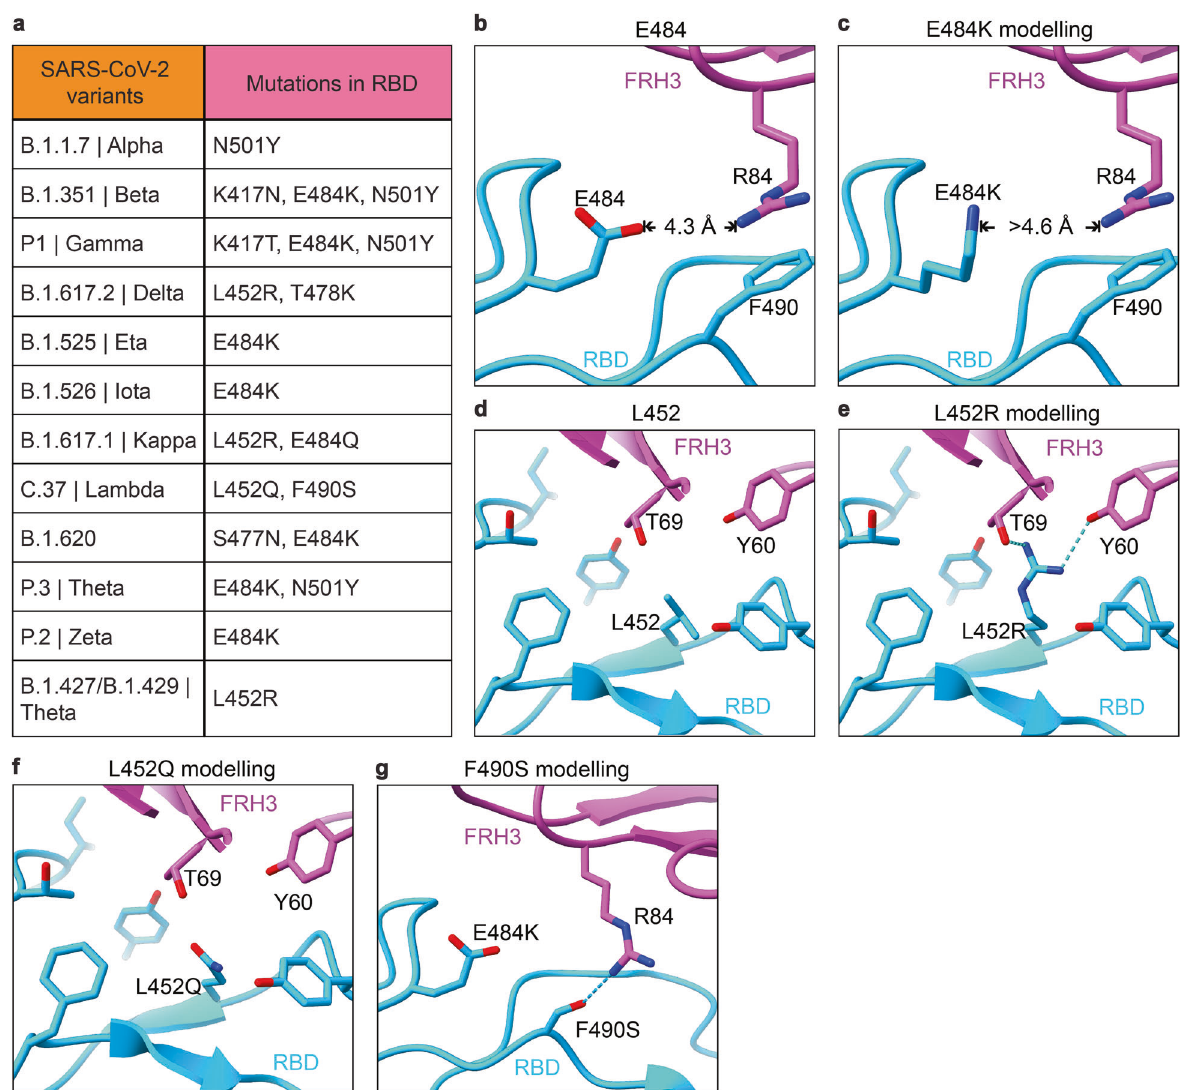
Fig. 5 Interactions of 35B5 Fab with RBD. a Mutations in the RBD of reported SARS-CoV-2 variants of concern or interest. b – g The residues E484 ( b ) and L452 ( d ) are not involved in the interactions of RBD with 35B5 Fab. E484 is more than 4.2 Å away from 35B5 R84, which forms cation – π interaction with RBD F490. The E484K mutation in RBD does not interact with 35B5 R84 through molecular modeling ( c ). The L452Q modeling suggests none interactions formed at this site with 35B5 ( f ). In structural modeling, the L452R mutation ( e ) and F490S mutation ( g ) in RBD generate potential additional interactions with 35B5 Fab. Potential hydrogen bonds are shown as dashed